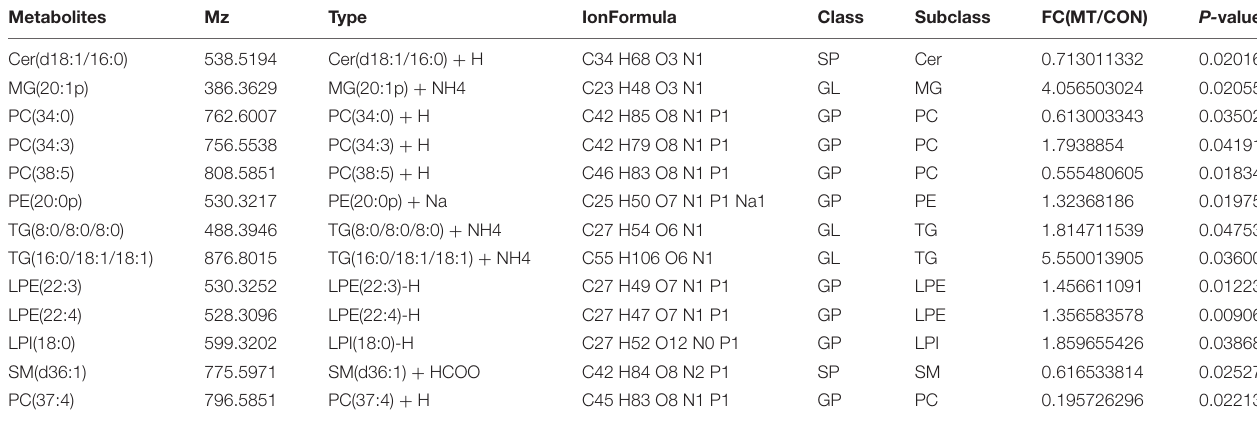
TABLE 2 | The fatty acid profiles of oocytes from the control and melatonin